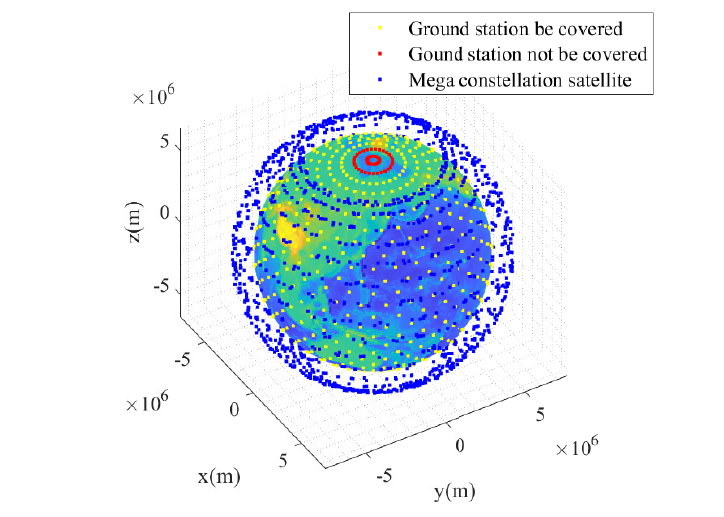
Figure 27. Coverage performance of the GW-2